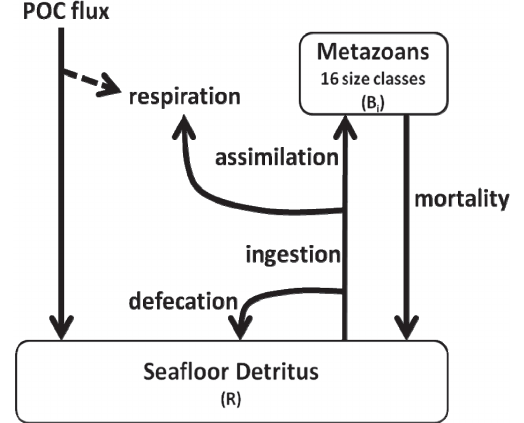
Figure 2. Flow diagram of model structure. The solid lines repre- sent processes explicitly represented in the model.